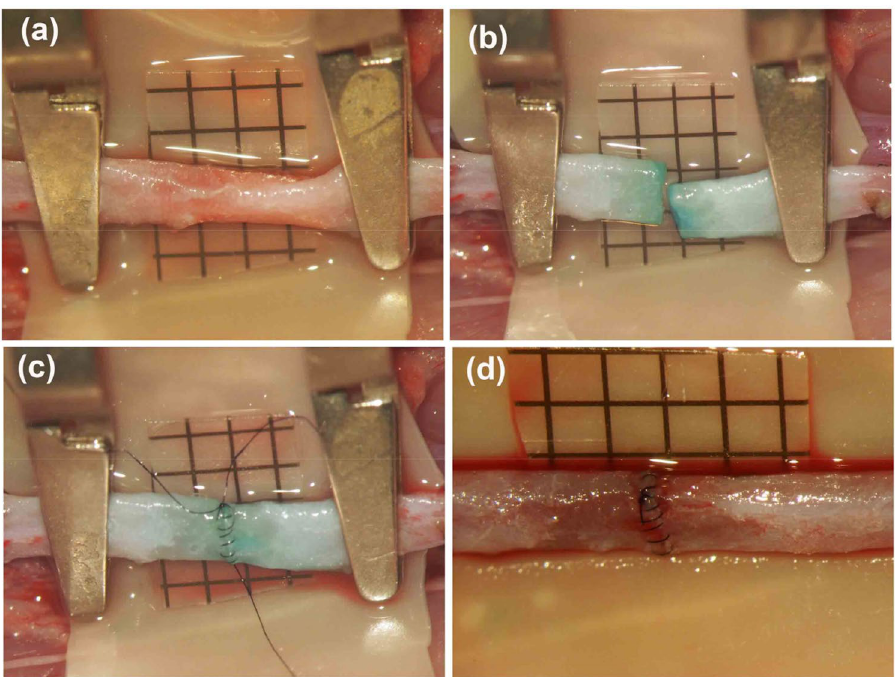
Figure 7. End-to-end anastomosis using abdominal aorta. After the abdominal aorta has been dissected ( a ), it was temporarily clipped and transected ( b ). The end-to-end anastomosis was completed with the intraluminal continuous suturing technique ( c ) and the blood flow was restored ( d ). (Scale bar = 1